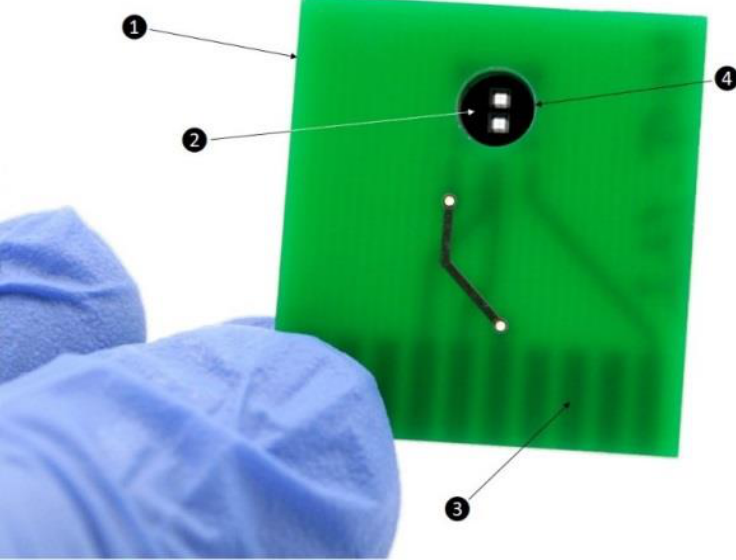
Figure 1. Layout of the chip for the thermal measurement. (1) Frontside of printed circuit board, (2) sensor die bonded on the back side, (3) integrated edge connector (visible on the back), (4) drilled